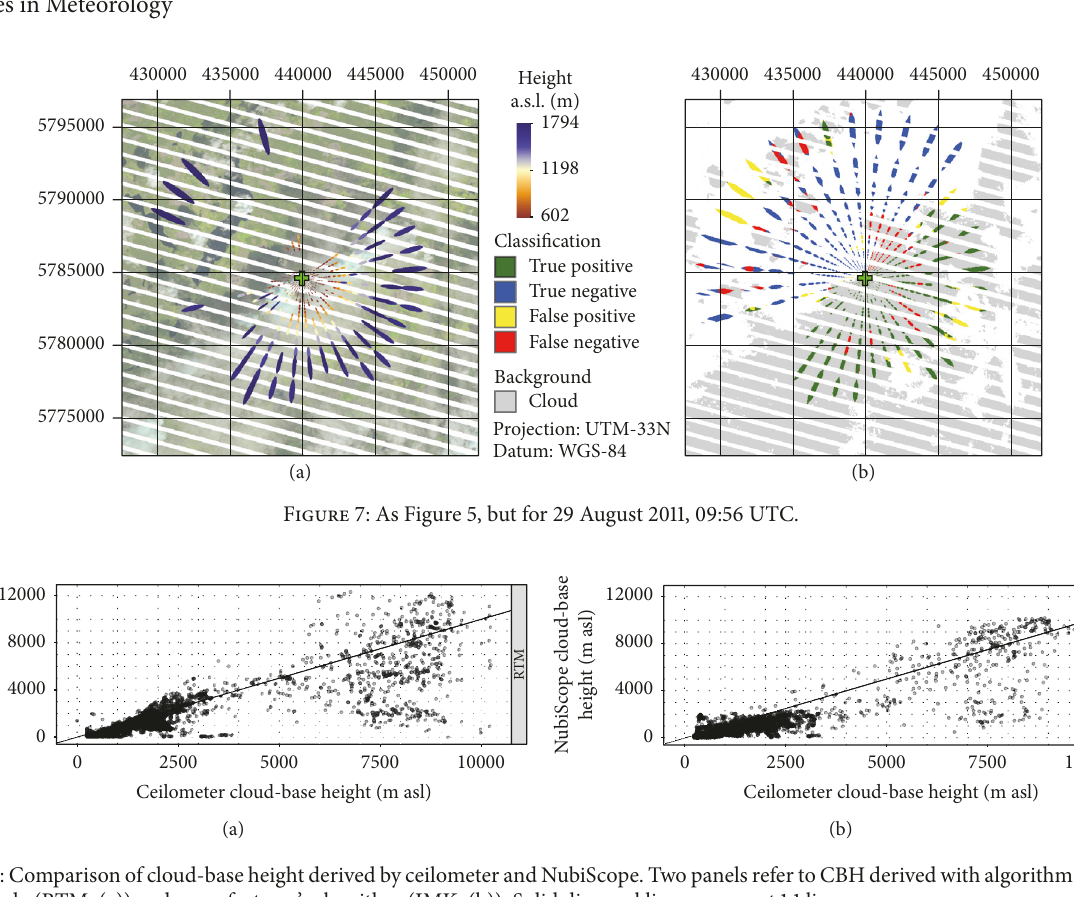
spatial extents of cloudless sky regions are depicted in high accordance with the Fmask